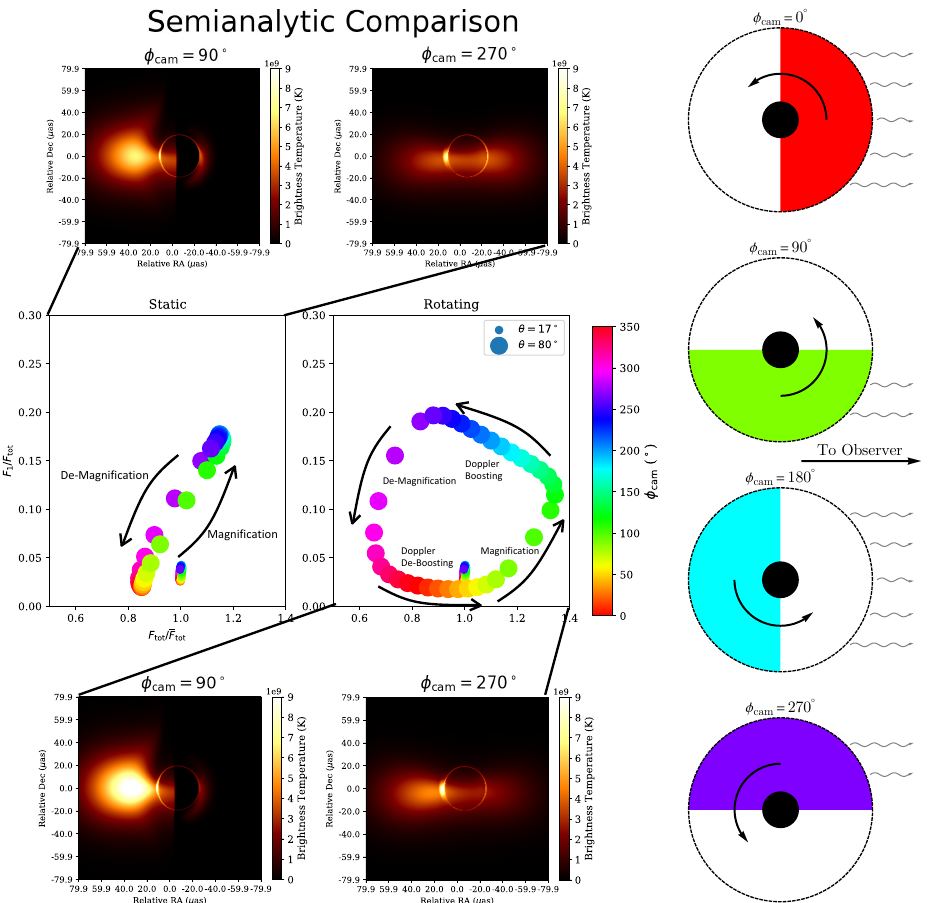
Figure 2. PFR in half-disk toy model, along with a schematic depicting the disk orientation on the right. Snapshots are for “static” disk ( top ) and rotating disk ( bottom ), both with θ cam = 80 ◦ . Both curves show a steep change in the PFR with φ cam because of gravitational lensing, but the addition of rotation introduces Doppler effects that modulate the relative flux, spreading the curve horizontally. The Doppler effects are also seen to a small degree for the “static” case because of the angular velocity of the zero-angular momentum